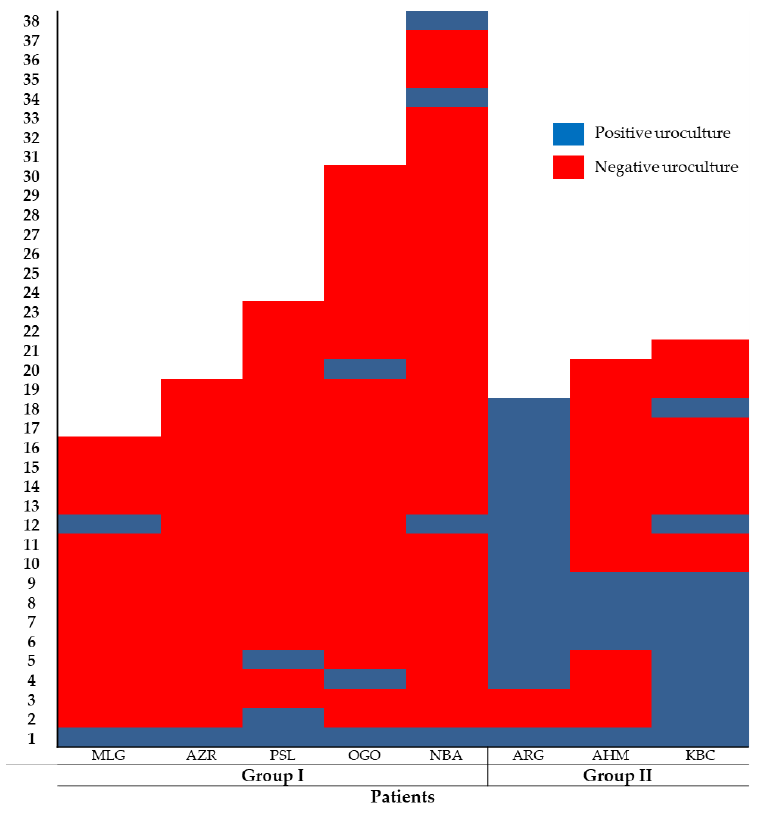
Figure 2. Protection induced by the ABL analyzed monthly by urine culture. Group I, five patients: MLG, 16 months stay and one reinfection at month 12; AZR, 19 months stay and negative urinary cultures from the two first months of treatment; PSL, 23 months stay and one reinfection at month 5; OGO, 30 months stay and reinfections at months 4 and 20; NBA, 38 months stay and reinfections at months 2, 34 and 38. Group II, three patients: ARG, 18 months stay and no bacteriuria at months 2 and 3; AHM, 20 months stay and reinfections at months 6 and 9; KBC, 21 months stay and sustained bacteriuria during the first 9 months in the study and at months 12 and 18.